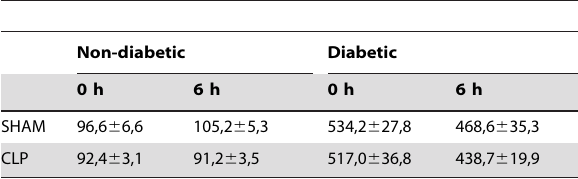
Table 2. Blood glucose levels (mg/dL) in diabetic* and non- diabetic rats and effect of sepsis induced by